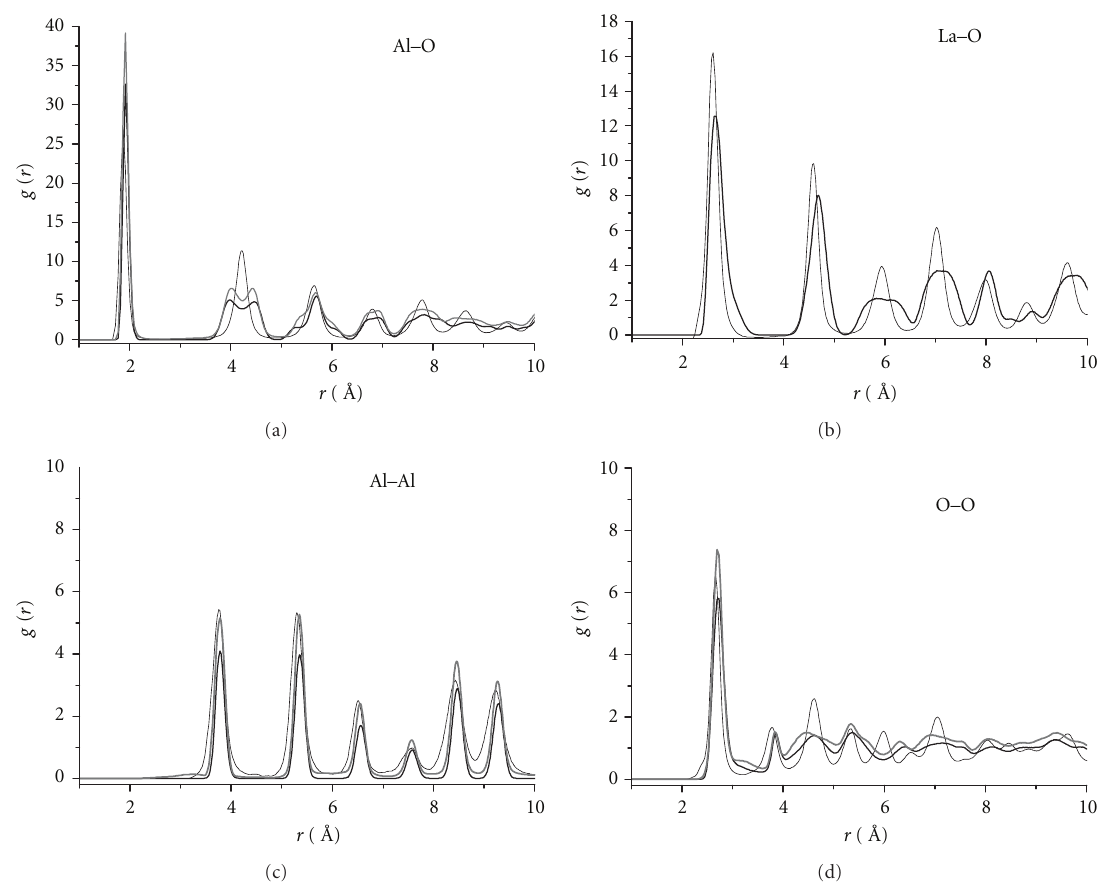
Figure 6: Radial distribution functions from molecular dynamics simulations for the pairs shown for samples LaAlO 3 (black thin line), La 0 . 3 Eu 0 . 7 AlO 3 (black line), and EuAlO 3 (gray line).